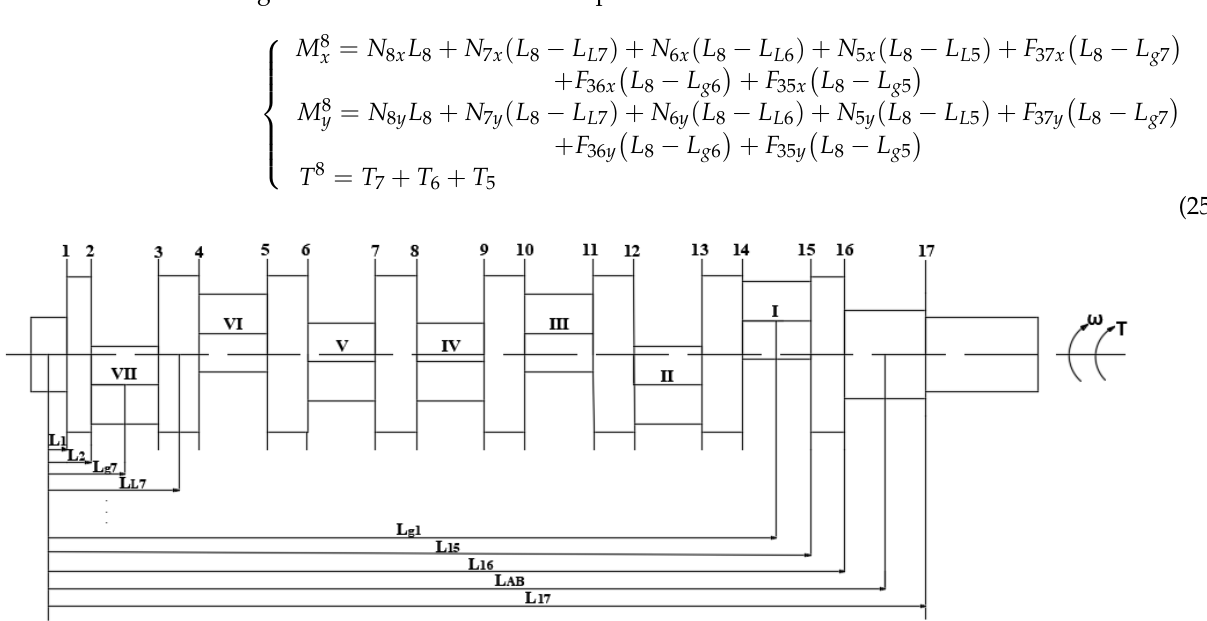
Figure 10. ( a ) Diagram of the x-direction support reaction force N kx of each support seat of the crankshaft, ( b ) Diagram of the y-direction support reaction force N ky of each support seat of the crankshaft.